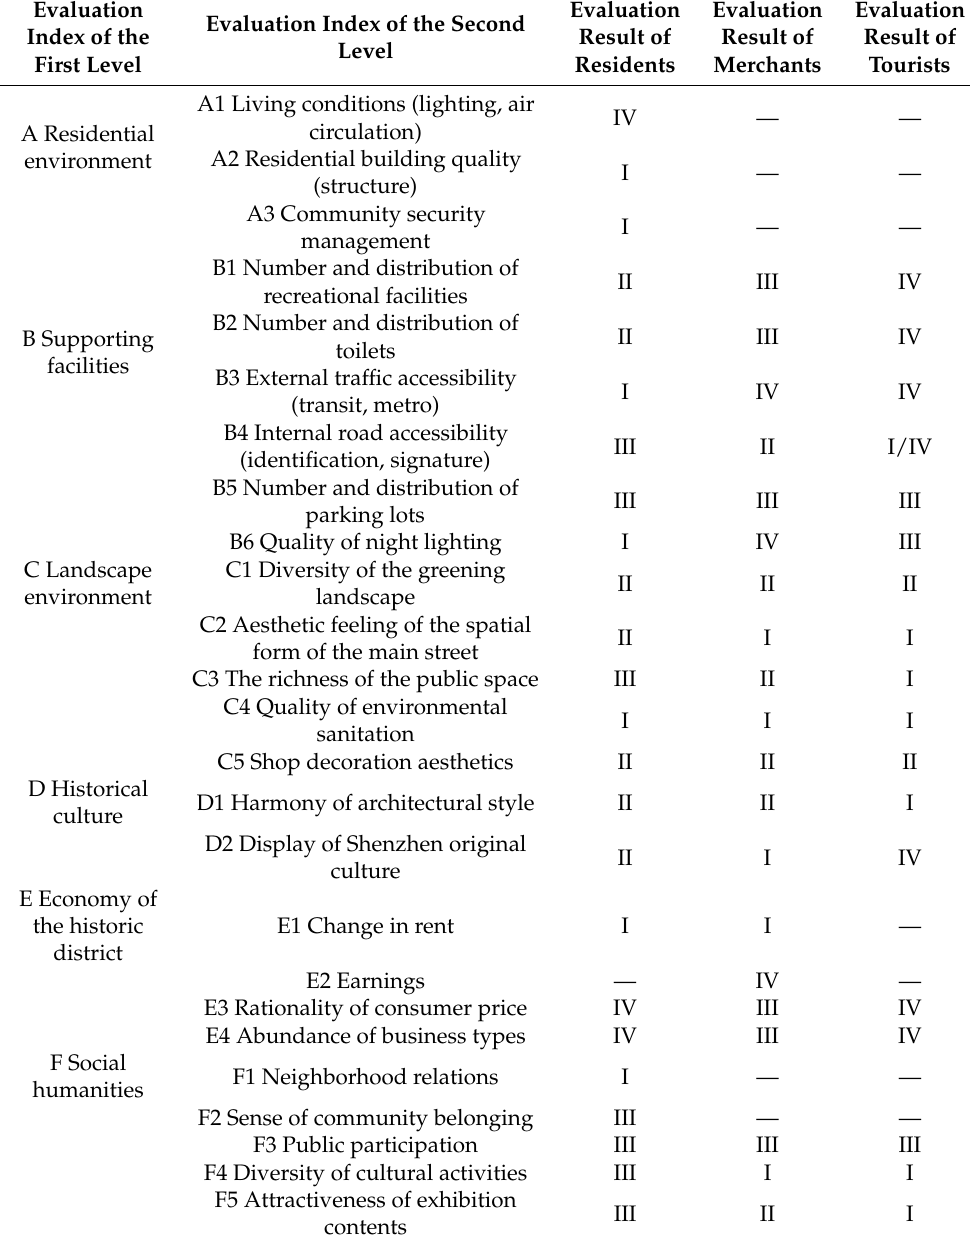
Table 4. Difference in IPA from the